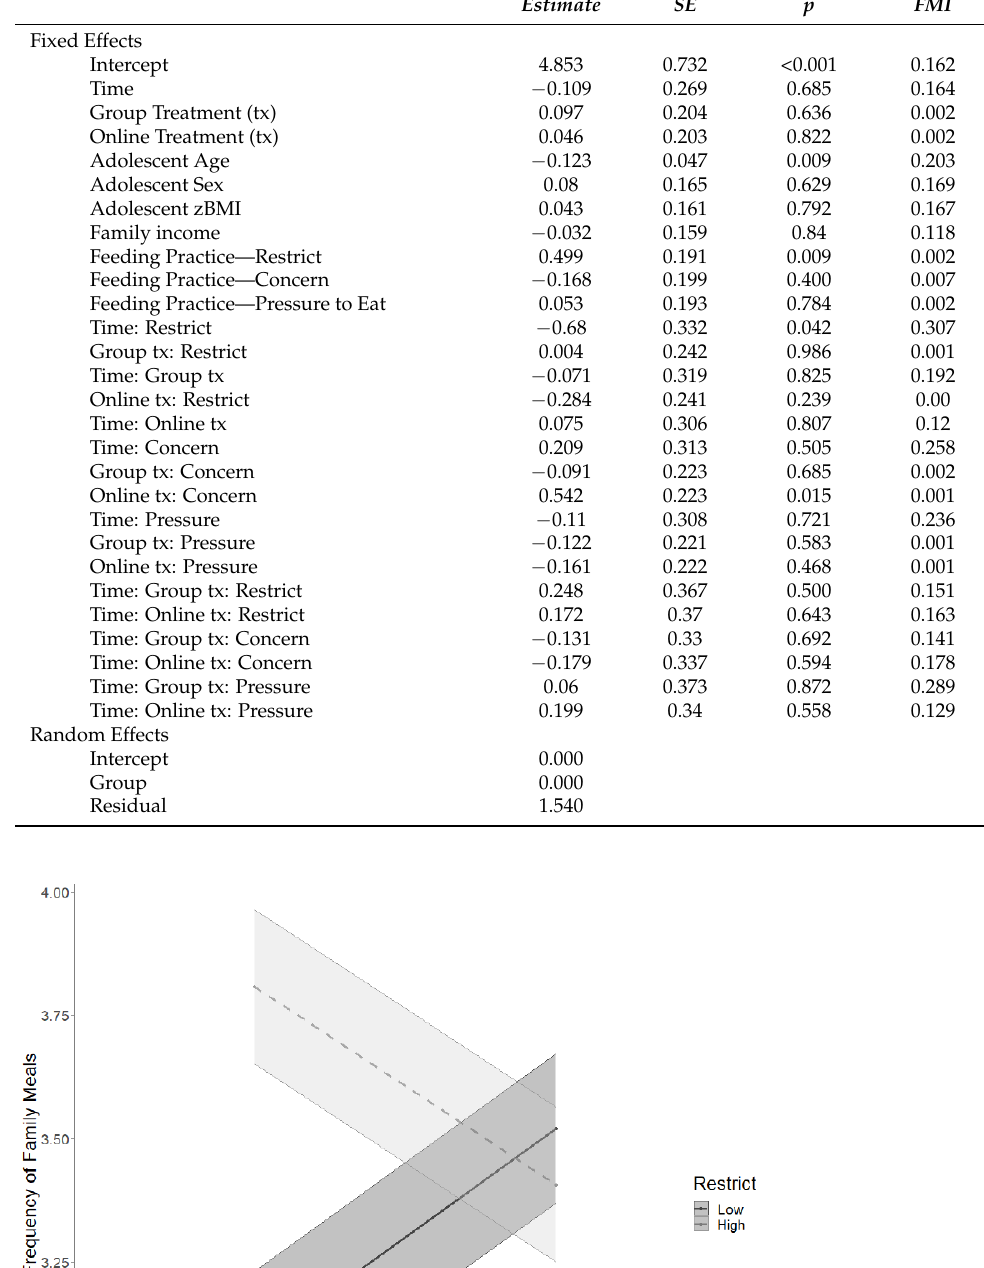
Table 4. Multilevel model with parenting feeding practices predicting family mealtime from baseline to 16 weeks.